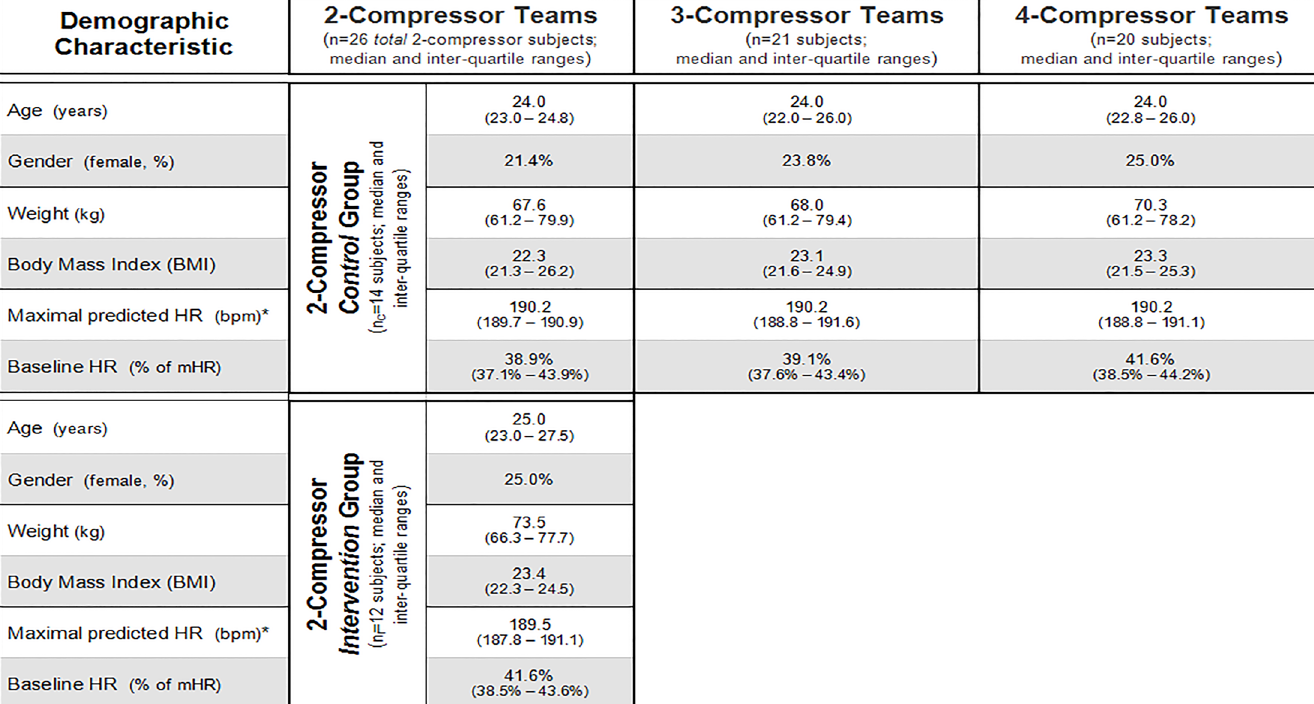
Figure 3. Subject demographic characteristics: There were no significant differences in reported and calculated values for all study teams (Kruskal-Wallis test for continuous variables and Fisher’s exact [2x4] test for binary variables). bpm , beats per minute; HR , heart rate; kg , kilogram; mHR , maximal predicted